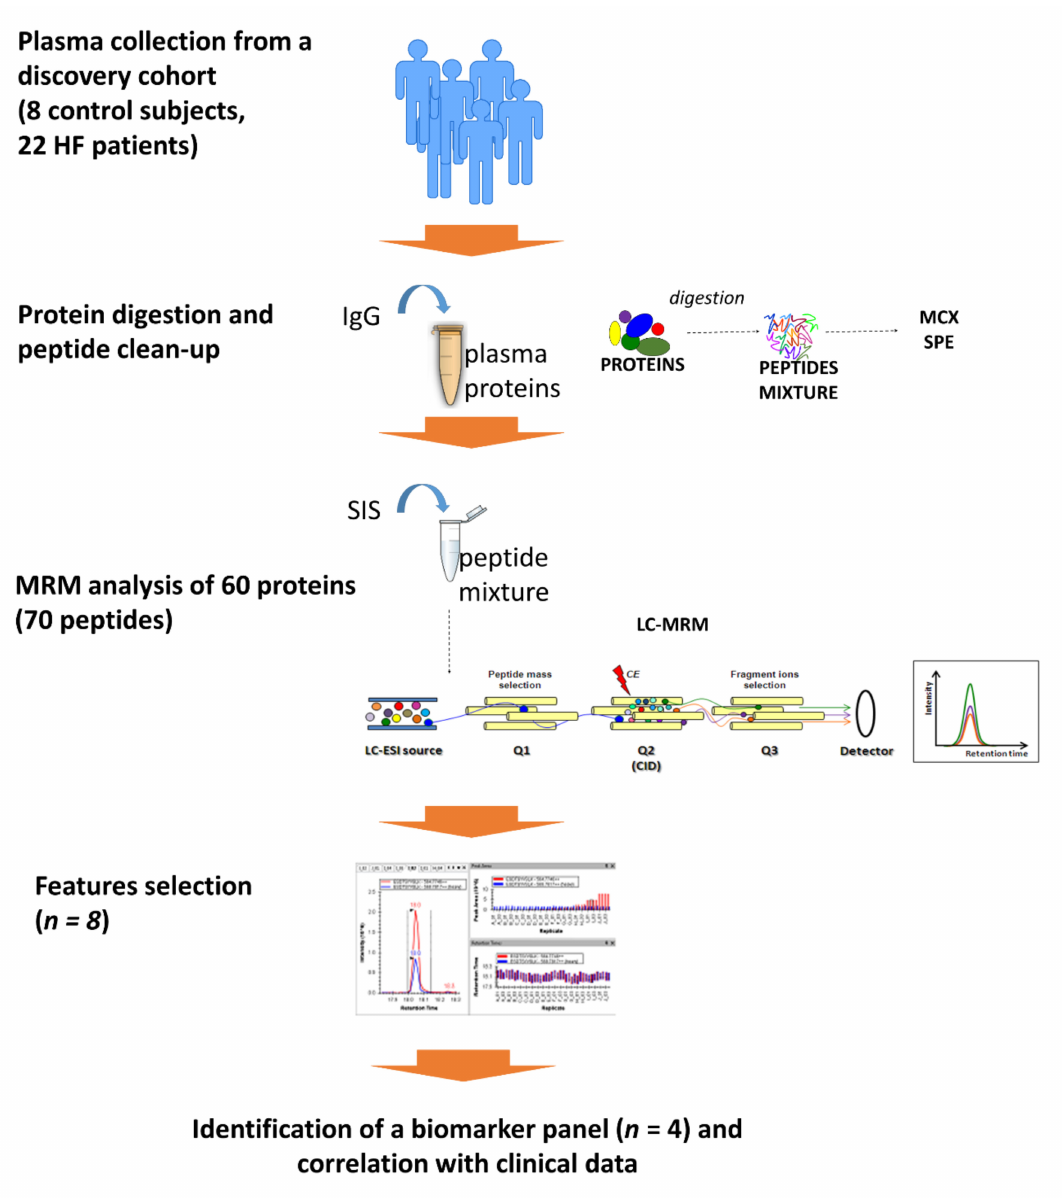
Figure 1. Workflow of the